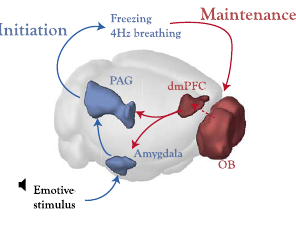
Fig. 6 Proposed model of brain – body – brain feedback loop of emotional initiation and maintenance. An emotive stimulus evokes responses in the amygdala and periaqueductal grey (PAG) which lead to changes in behaviour (freezing) and somatic physiology (breathing). The 4 Hz breathing entrains the OB which in turn organizes neural fi ring in the dmPFC which allows to maintain the ongoing behaviour, perhaps via its connections with the amygdala for example. The dotted line between the OB and dmPFC indicates that this connection is unlikely to be monosynaptic and has not been well described. Image credit: Allen